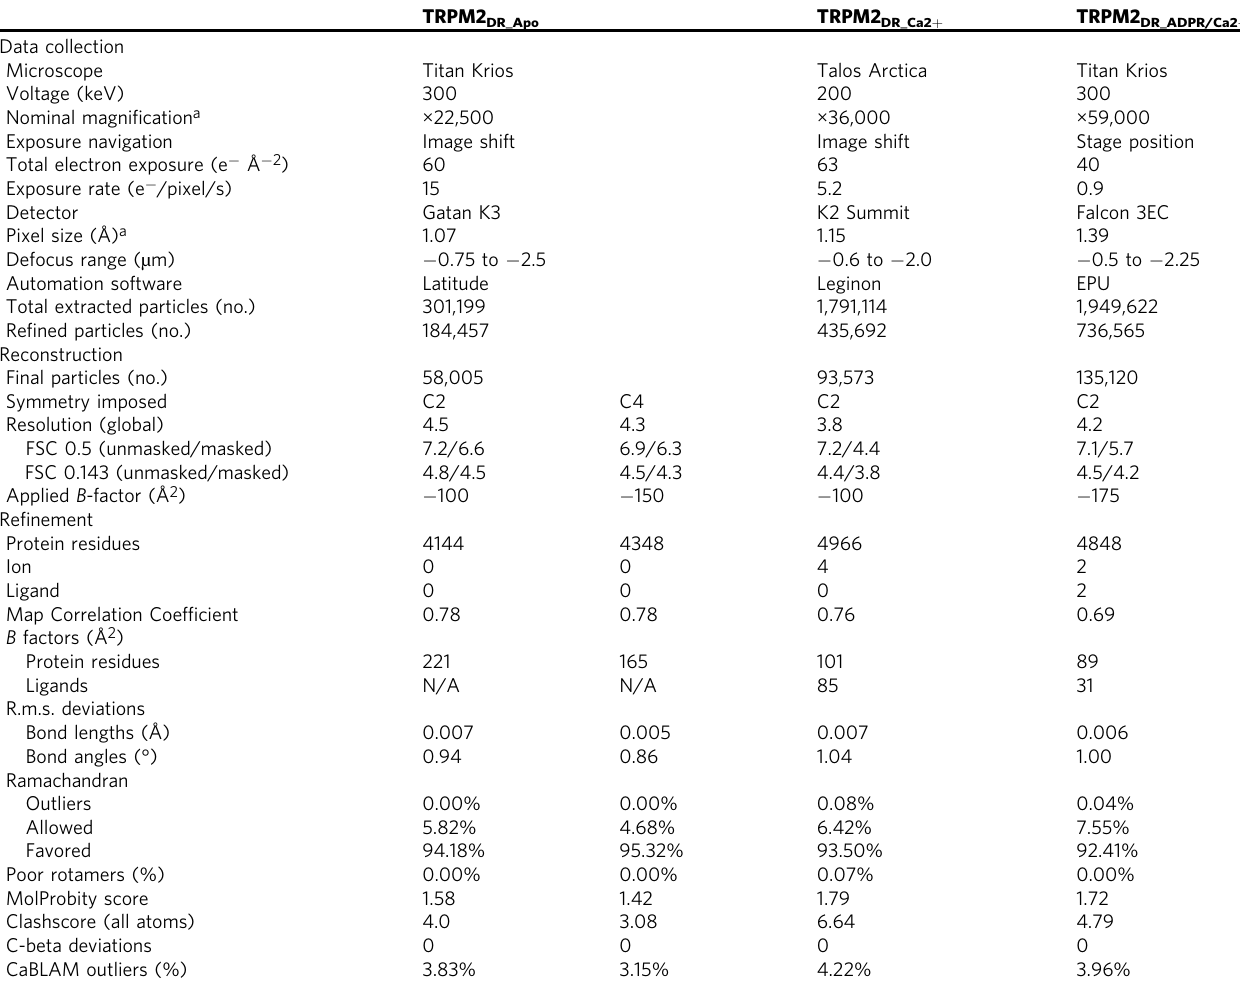
Table 1 Data collection and re fi nement